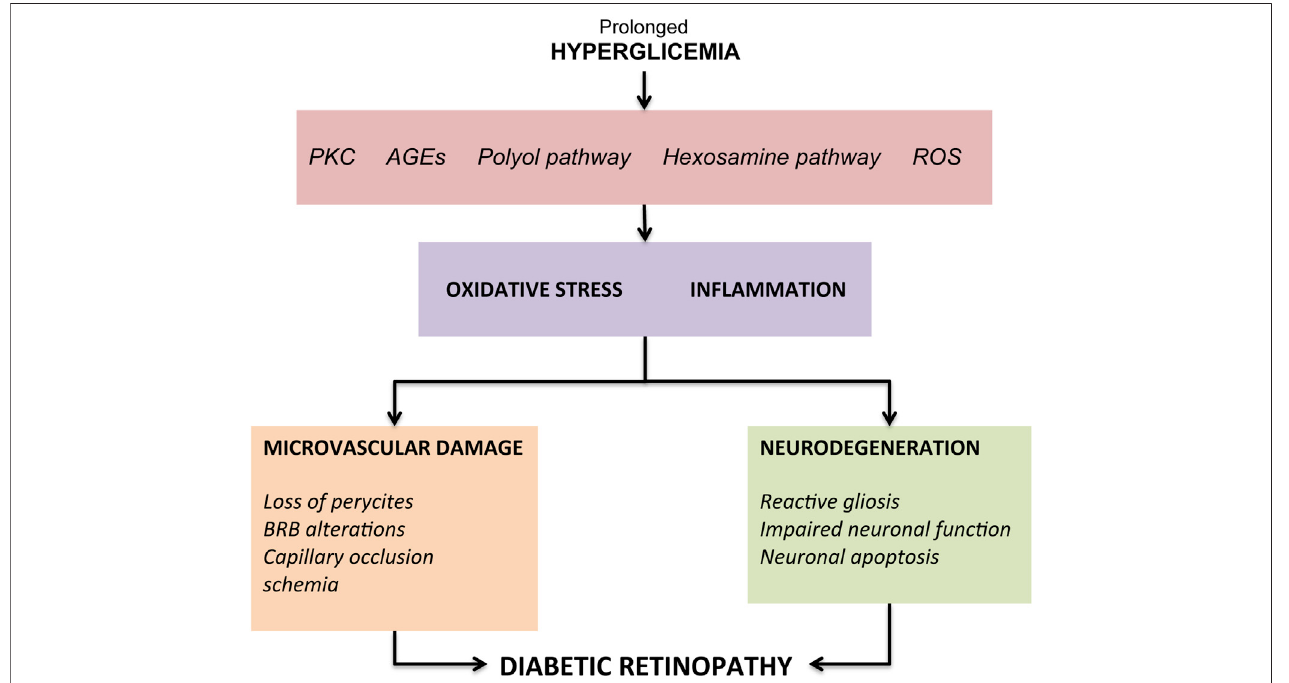
FIGURE 1 | Overview of the pathogenic mechanisms leading to diabetic